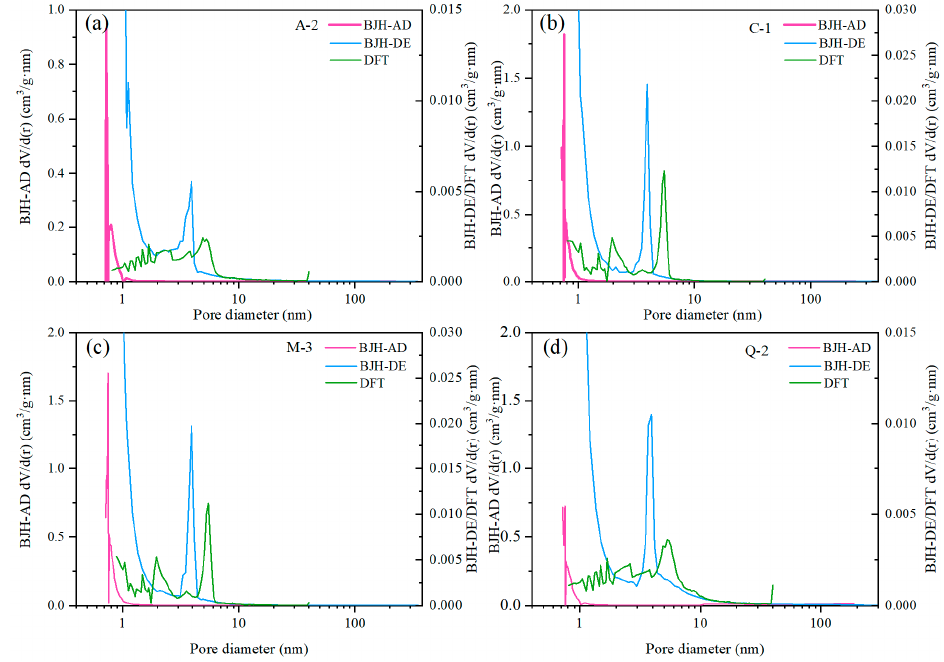
Figure 6. Comparison of micro − mesopore size distribution calculated by the BJH and DFT models using the adsorption and desorption branches from the N 2 adsorption experiments. ( a ) Sample A-2 of argillaceous shale; ( b ) Sample C-1 of calcareous shale; ( c ) Sample M-3 of siliceous shale; ( d ) Sample Q-2 of mixed shale